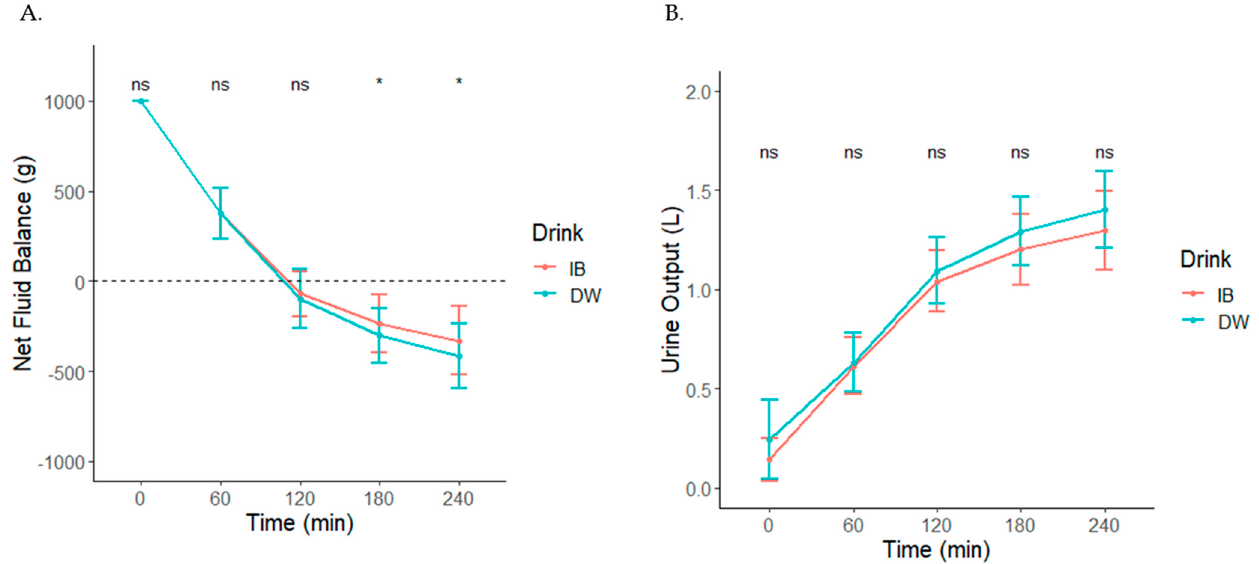
Figure 2. Net fluid balance ( A ) and cumulative urine output ( B ) following consumption of IB or water. * Denotes a significant Drink x Time interaction, p < 0.05. Non-significant interactions are denoted by ns.